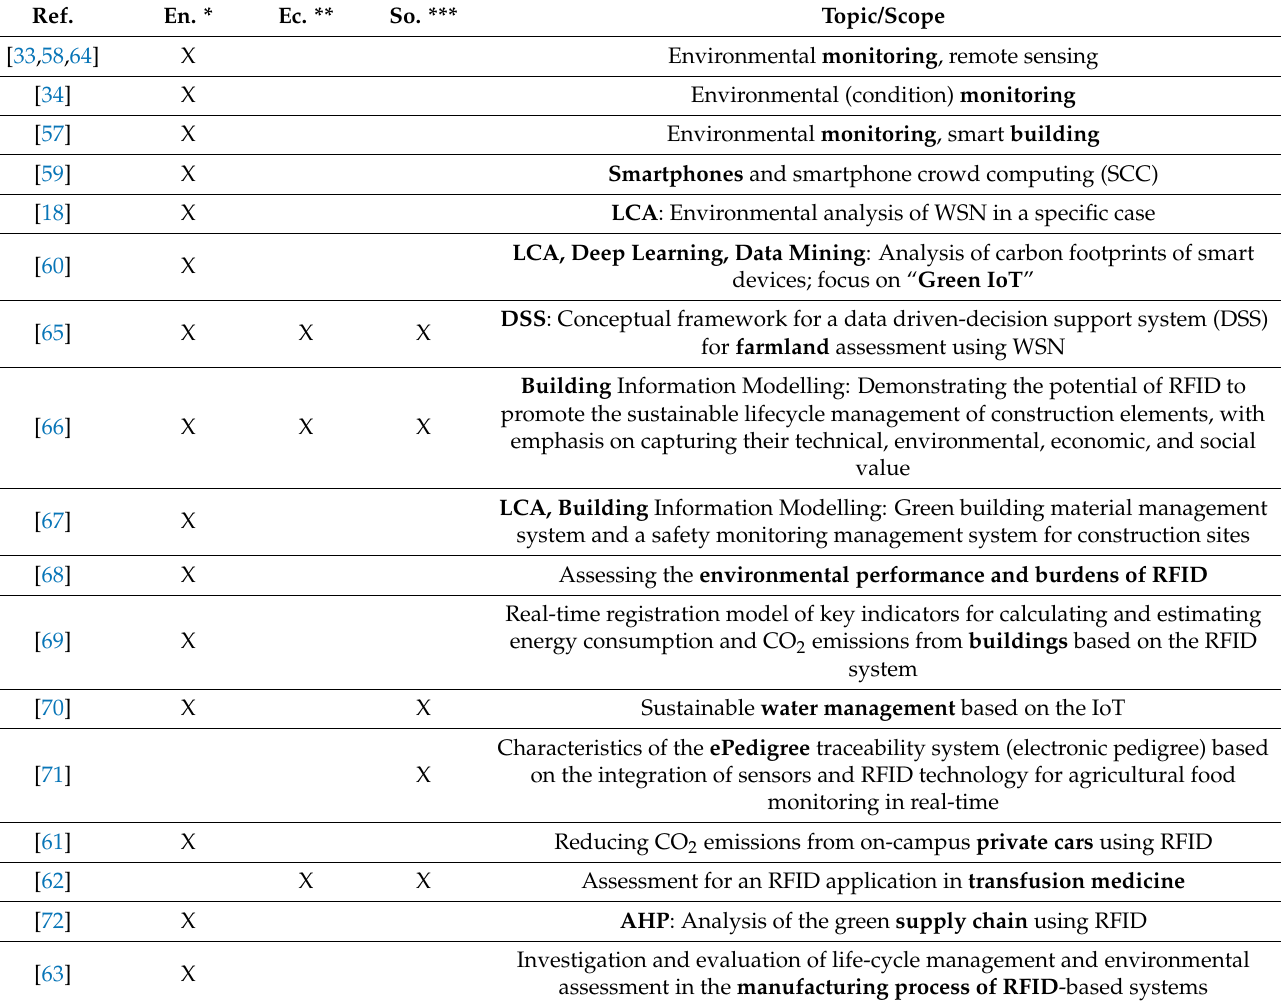
Table 1. The selected papers for RFID and WSN assessments in terms of sustainability.